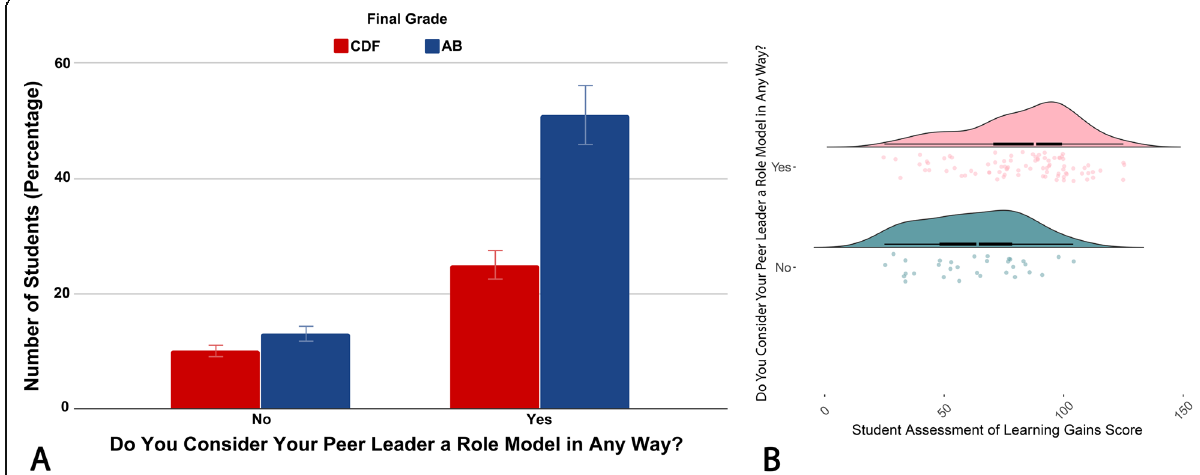
Fig. 2 Impact of Role Model Status on Student Learning Outcomes. BIO 121 students enrolled in Peer Led Team Learning who considered their peer leaders to be a role model also reported significantly higher self-assessed learning gains (Panel b ; dots are jittered for readability), while no significant differences were found in final course grade between students who viewed their peer leaders as a role model and students who did not (Panel a ; p = .254)